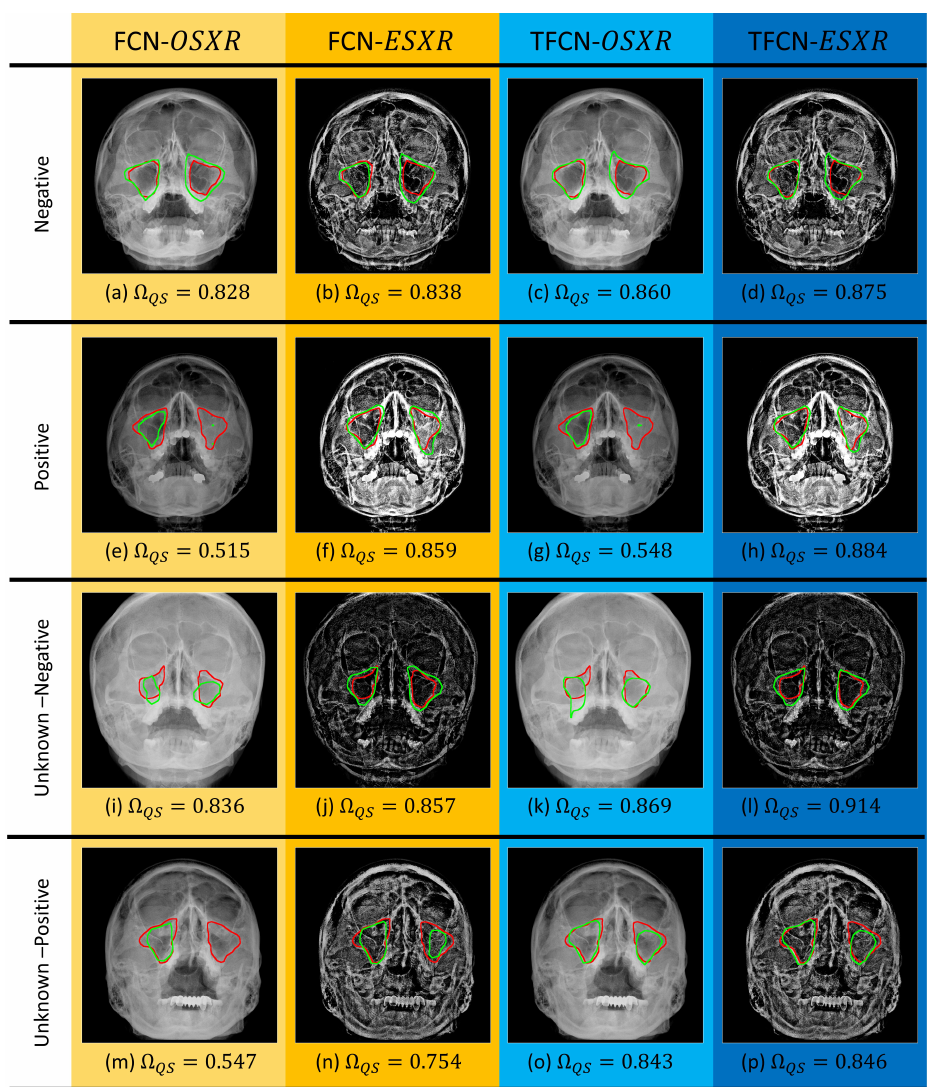
Figure 4. A montage of segmentation results using the FCN [16] against the T-FCN with all combinations of training and test datasets as shown above from ( a – p